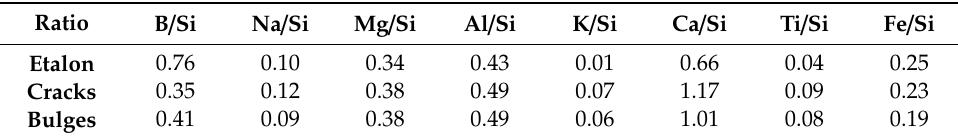
Table 3. Relative amount of elements on the surface compared to Si in new and degraded samples with cracks and bulges